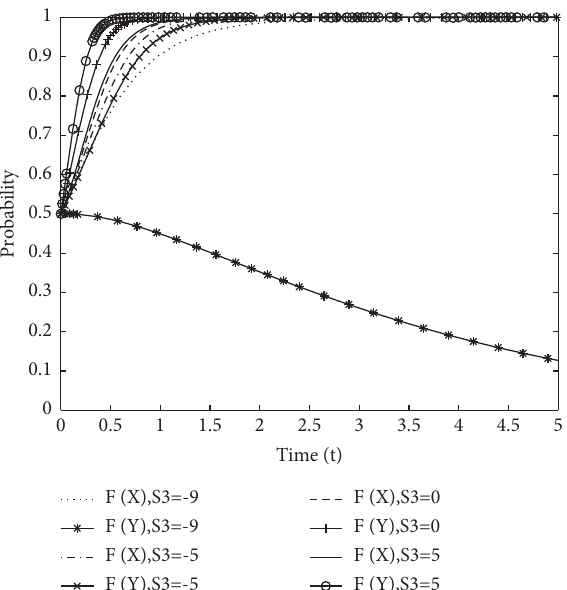
Figure 5: Evolutionary path of S